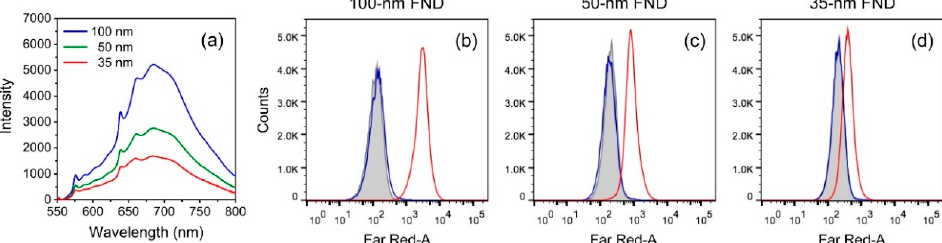
Figure 4. ( a ) Fluorescence spectra of FNDs suspended in water (100 μ g/mL). The fluorescence